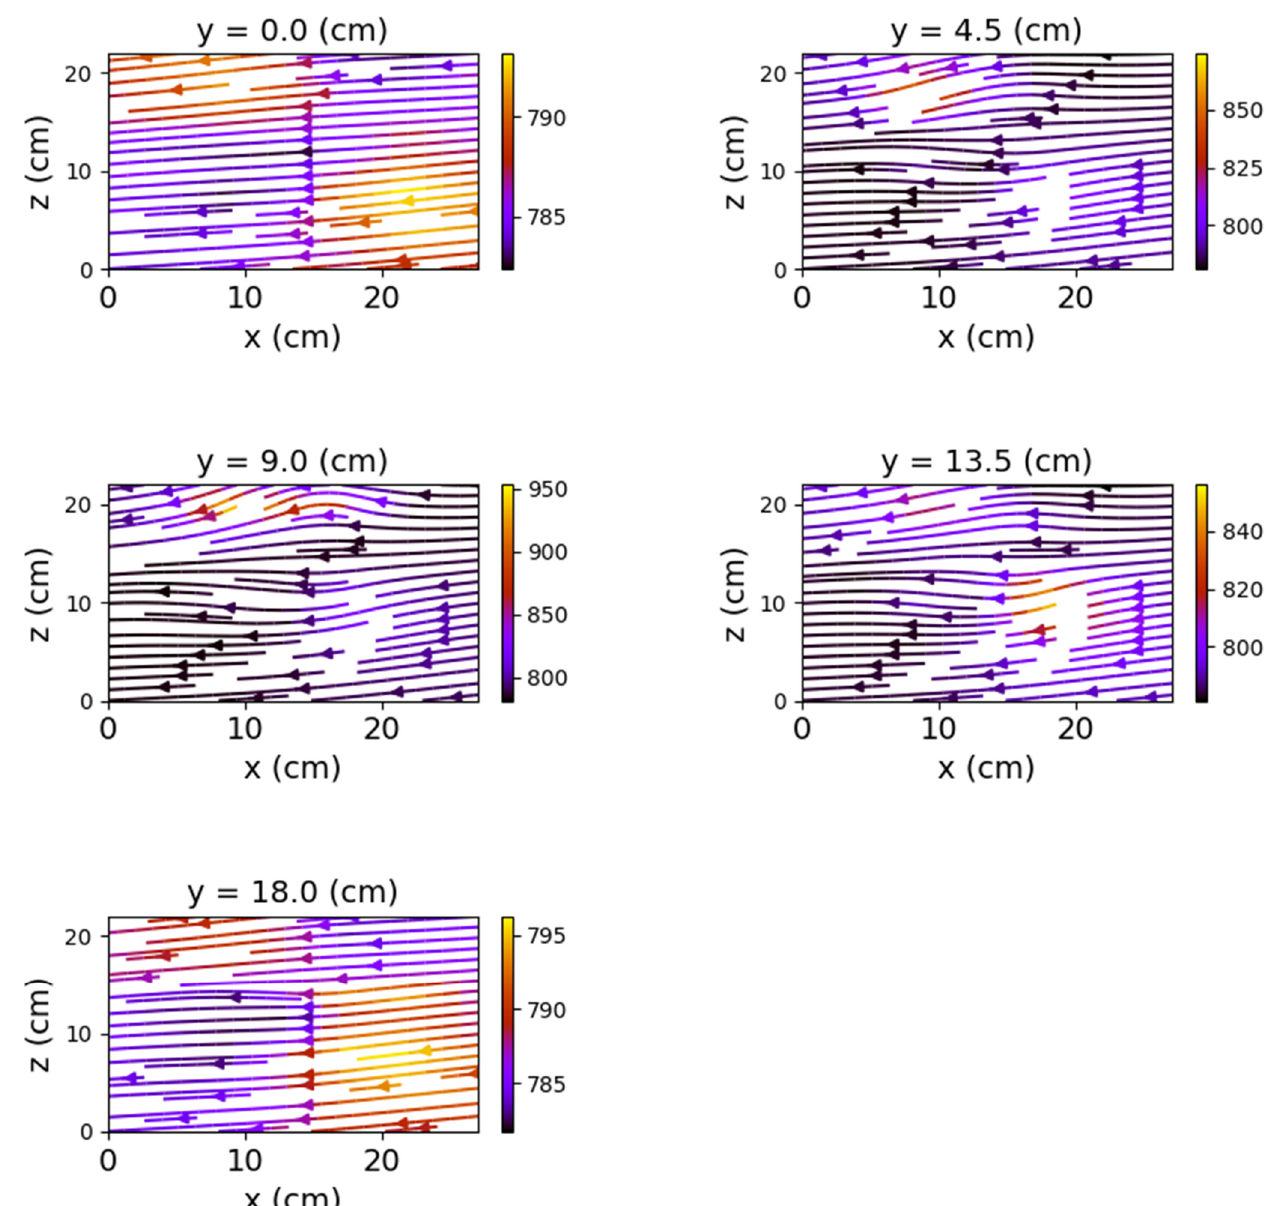
Figure 16. Field lines for x O z plane—relay with coil 1–3 powered.